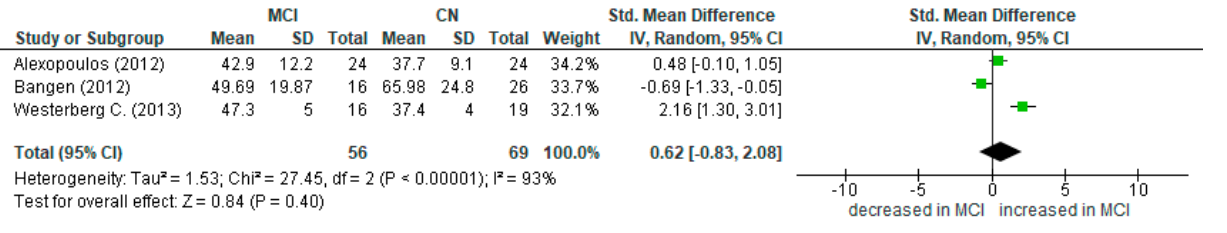
Figure 5. MTL: mild cognitive impairment vs. cognitively normal (Alexopoulos P. (2012) [33], Bangen K.J. (2012) [37], Westerberg C. (2013)